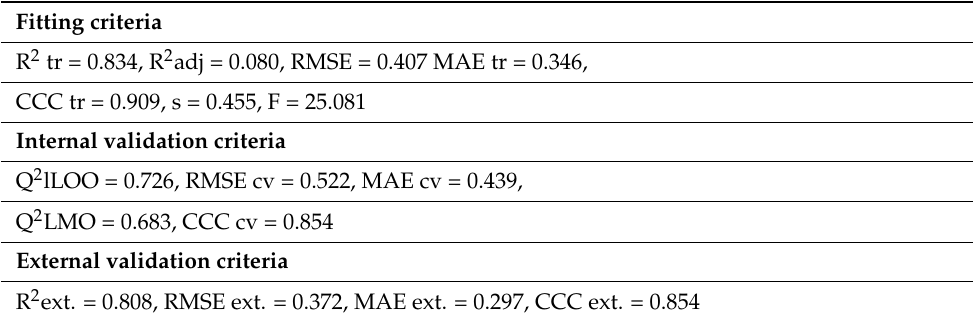
Table 6. The average distances (A) between Arg/Gln192---Ca 2+ , His115---Ca 2+ in QPON1, and Table 5. Fitting, internal validation, and external validation criteria for R isozyme model.